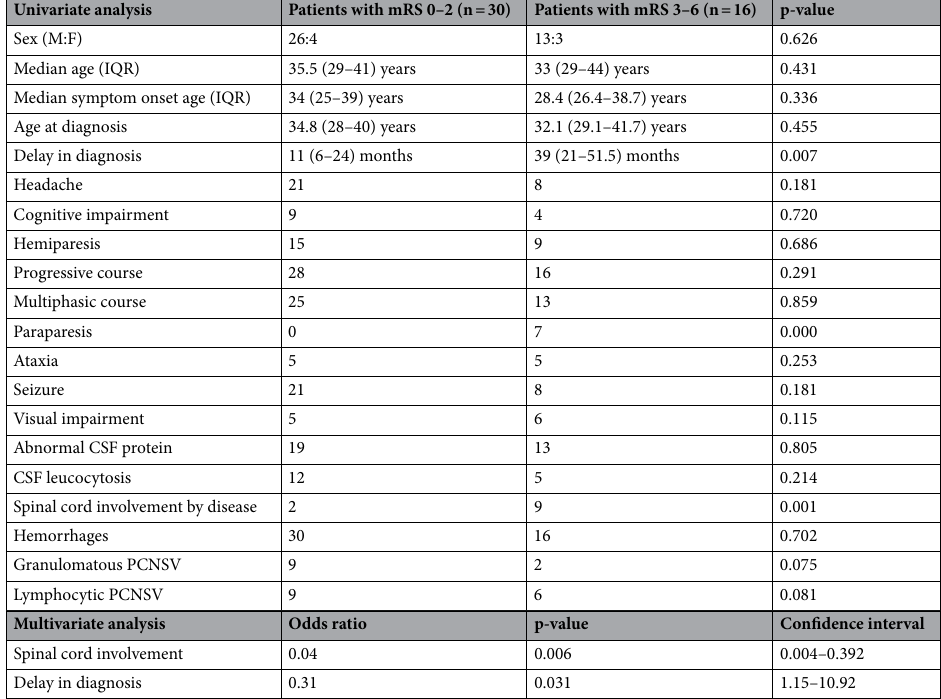
Table 2. Predictors of favourable functional outcome (mRS